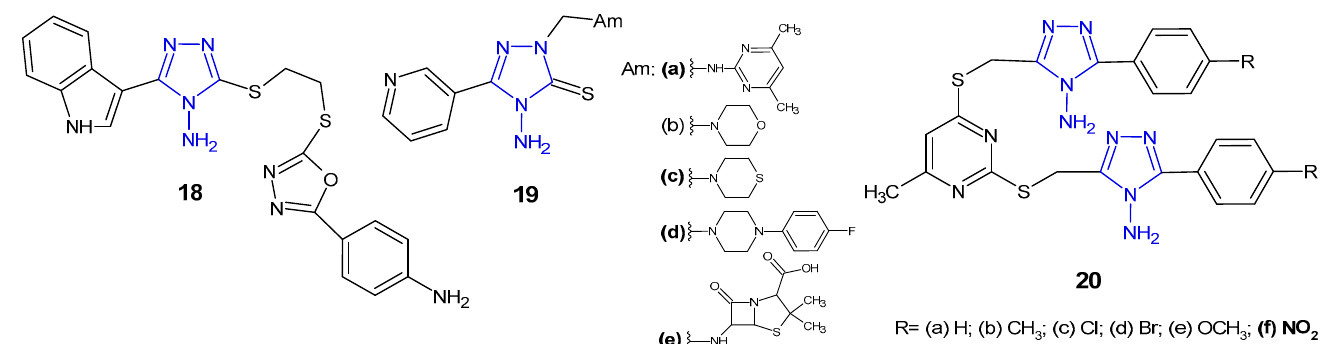
Figure 9. Antibacterial derivatives of 4-amino-1,2,4-triazole - continued. 4-Amino-5-pyridin-3-yl-2,4-dihydro-3 H -1,2,4-triazole-3-thione was prepared by Ceylan (2016) and converted to the corresponding Mannich 19 (Figure 9) and Schiff bases to assess their antimicrobial activity against three Gram-positive ( S. aureus , B. cereus , M. smeg- matis ) and four Gram-negative bacteria ( E. coli , Y. pseudotuberculosis , P. aeruginosa , E. faecalis ). Mannich bases 19a , 19c – d , which contained 2-amino-4,6-dimethylpyrimidine, thiomorpho- line, 1-(4-fluorophenyl)piperazine, and 6-aminopenicillanic acid moiety in triazole skeleton